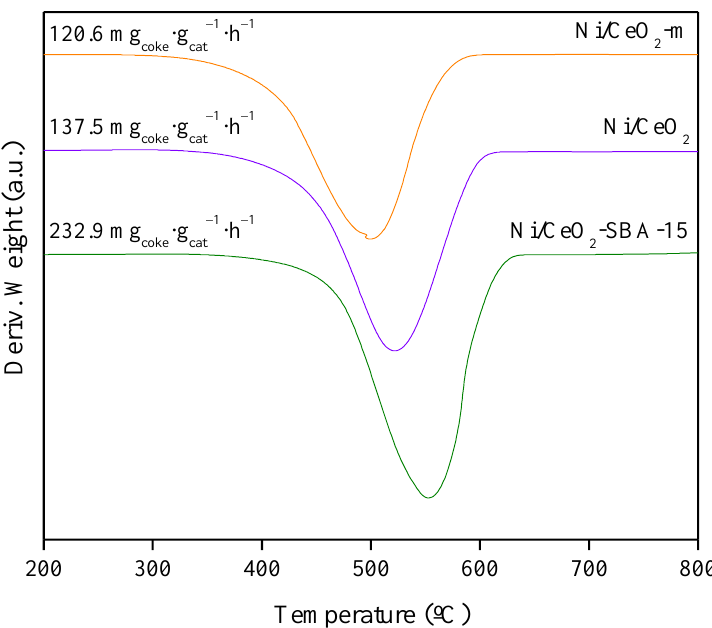
Figure 8. DGT curves of used Ni-supported CeO 2 -based catalysts and coke amount deposited at 500 °C. As stated before, apart from coke formation as a cause of deactivation, oxygen in the feed mixture could lead to active phase oxidation, leading to non-active sites [20]. In this regard, XRD analyses were performed on the used catalysts, whose diffractograms are represented in Figure 9. Peaks corresponding to graphitic carbon (JCPDS 00-041-1487) at 26.5 ◦ can be distinguished as a consequence of carbon deposition during the acetic acid oxidative steam reforming. This peak is more pronounced in the Ni/CeO 2 -SBA-15 sample, according to higher coke deposition. These peaks could not be clearly discerned in the case of Ni/CeO 2 , given the intensity of CeO 2 peaks. Peaks ascribed to cubic Ni 0 (JCPDS 01-071-3740) arise in all the samples at 44.6 and 51.8 ◦ , as most Ni species are under a reduced state during the whole reaction. Unlike the other samples, Ni/CeO 2 - SBA-15 also exhibits peaks at 37.3, 43.4, and 63 ◦ because of the presence of cubic NiO (JCPDS 01-075-0197), indicating that apart from having the highest coke deposition value, the oxidation of the Ni 0 sites is taking place, which also contributes to catalyst deactivation, thus explaining the conversion and hydrogen yield drops observed in Figure